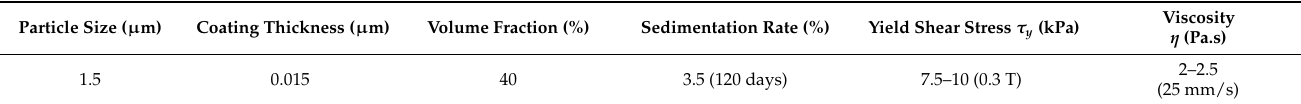
Figure 5. Schematic diagram and performance tests of a single-coil MR damper. Table 2. Basic properties of MR fluid.